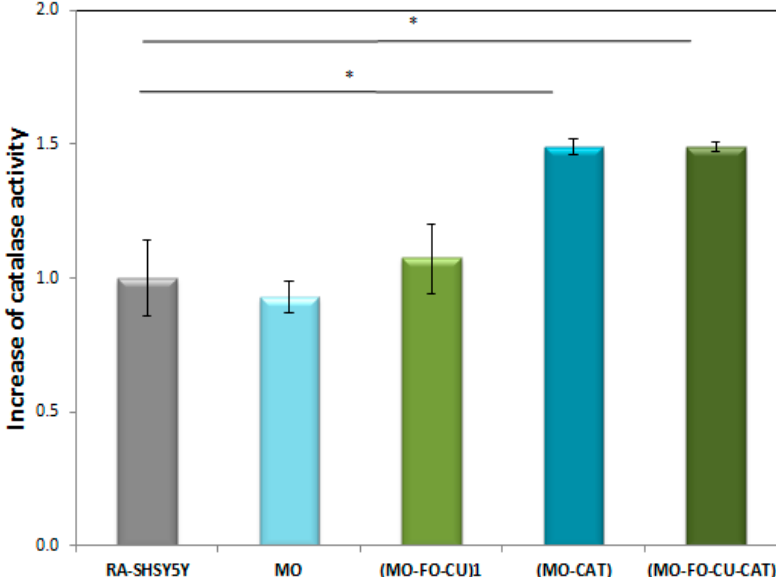
Figure 7. Fold increase in catalase enzymatic activity (peroxidatic function) determined in supernatants of cell lysates of differentiated SH-SY5Y cells (RA-SH-SY5Y) after exposure to blank nanoparticles (MO), catalase-loaded (MO-CAT) cubosome nanoparticles, dual drug-loaded (MO-FO-CU) or enzyme-loaded (MO-FO-CU-CAT) cubosome nanoparticles.